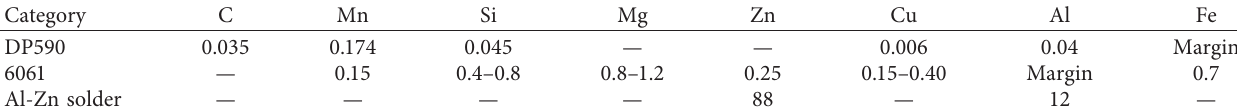
Table 1: Chemical composition of materials (mass fraction, %).